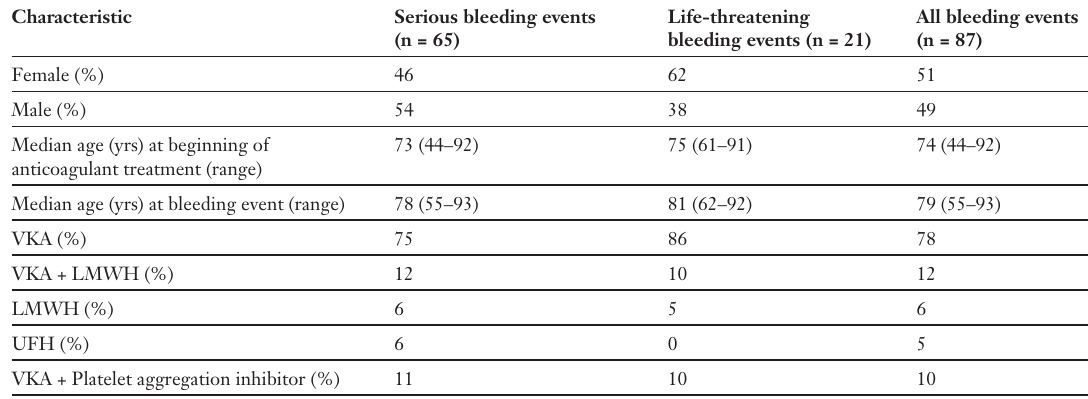
Table 1 Baseline characteris- tics of patients and type of anticoagulant